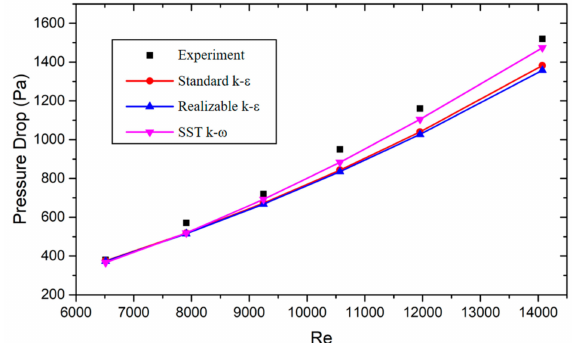
Figure 9. Pressure drop by di ff erent turbulence